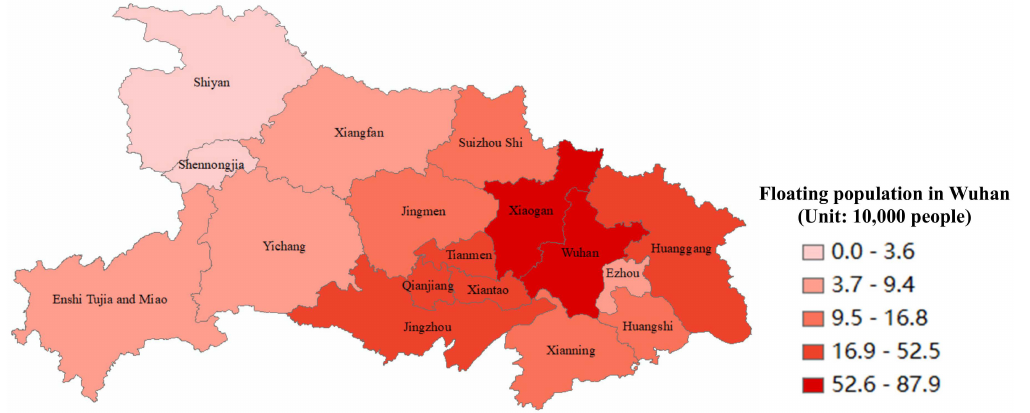
Figure 2. The distribution of Wuhan’s migrants within Hubei